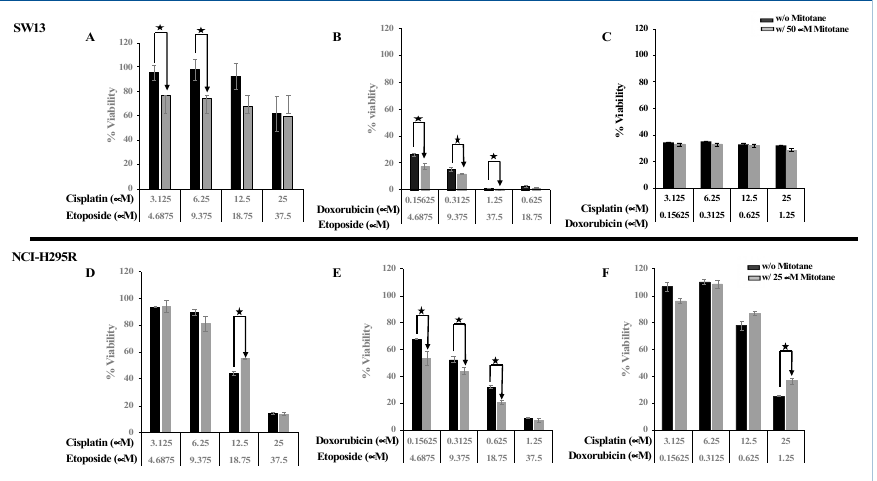
Figure 4. SW13 and NCI-H295R cells were treated with two chemotherapeutic drugs (P + E ( A , D ) or P + D ( C , F ) or E + D ( B , E )) with or without mitotane used in the Italian protocol and the viability was determined by MTS assay. Percentage viability of cells with respect to untreated control was calculated. Experiments were repeated twice in triplicate, and the values are presented as mean ± standard deviation. * p < 0.05.